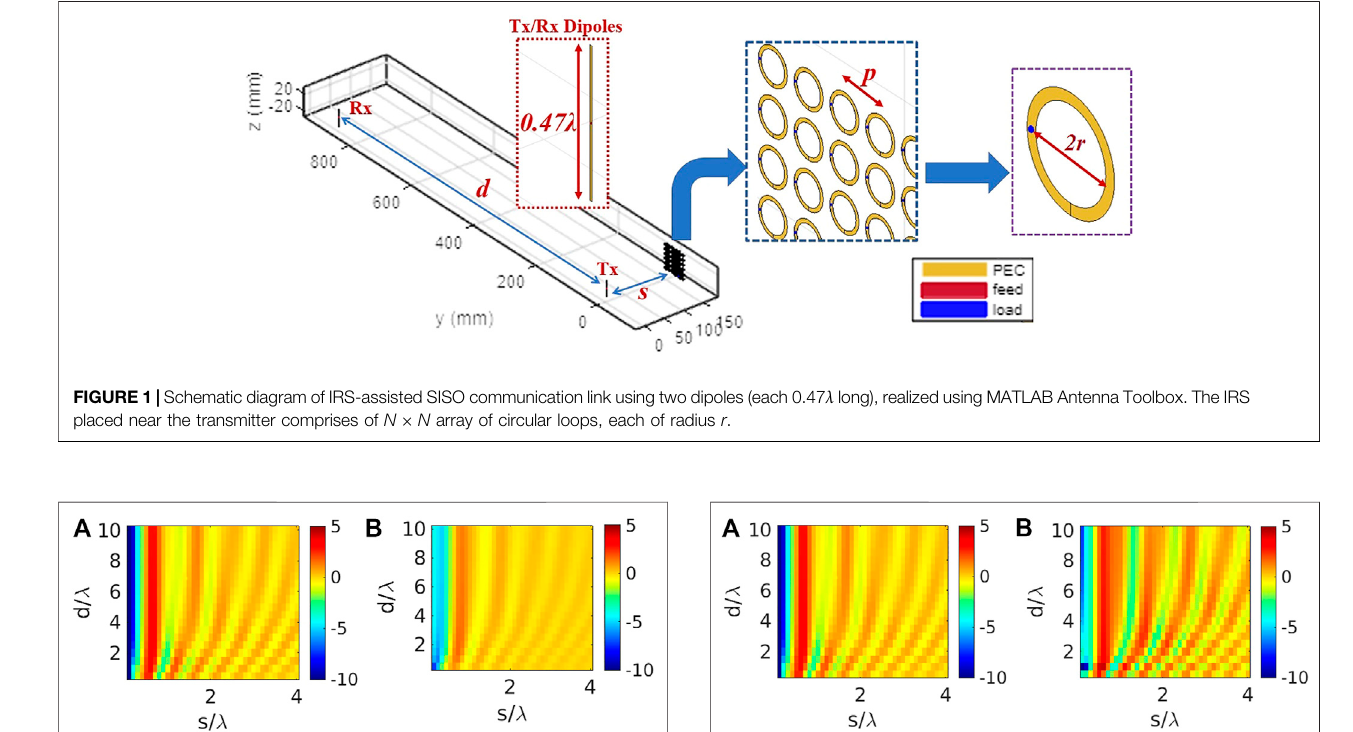
FIGURE 2 | Variation of Δ P (in dB) for the con fi guration in Figure 1 with respect to d / λ and s / λ , keeping p (cid:1) 2 r +2 mm for: (A) N (cid:1) 4, r (cid:1) 0.1 λ , (B) N (cid:1) 8, r (cid:1) 0.05 λ .